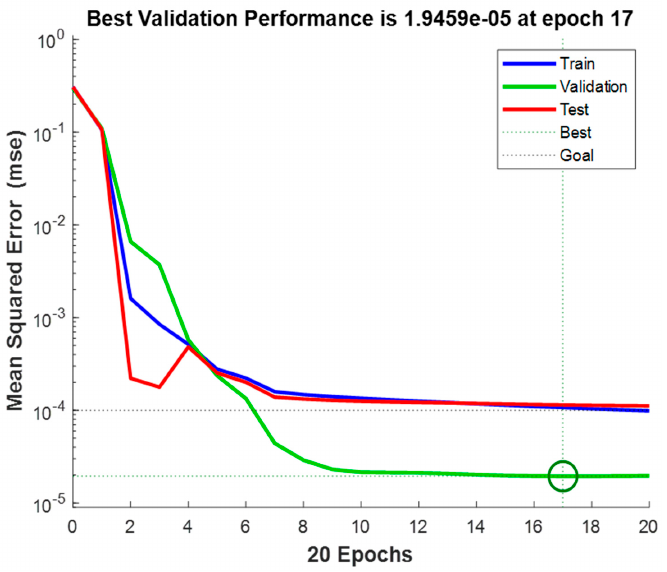
Figure 10. Optimal NARX network performance.